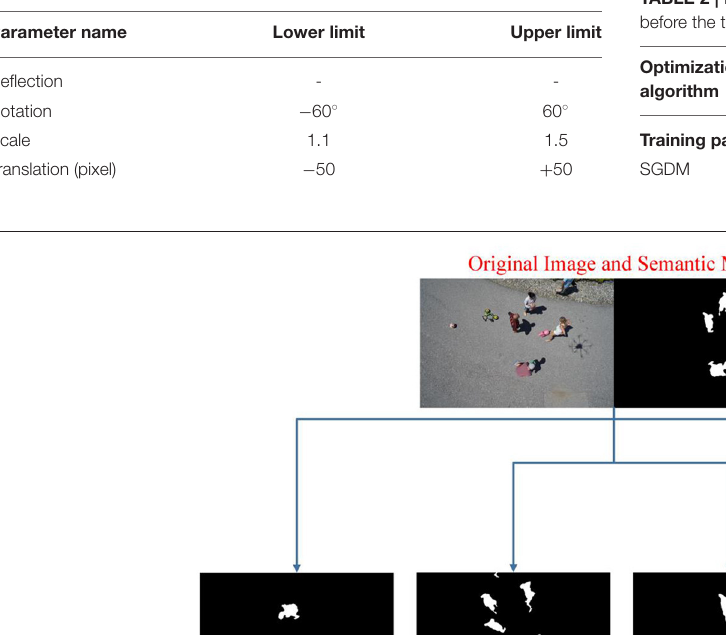
TABLE 1 | Data augmentation techniques and lower-upper limit values of each technique (In the data augmentation step, random values are determined in the specified range for each data augmentation technique).